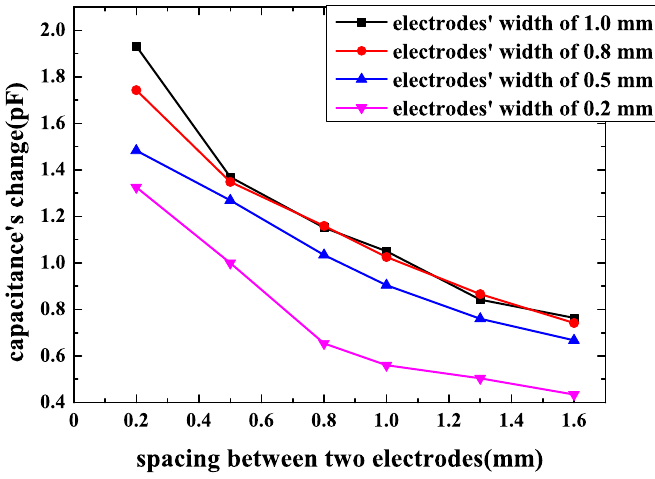
Figure 7. Capacitance’s change of the spiral pattern sensor with electrodes’ spacing.